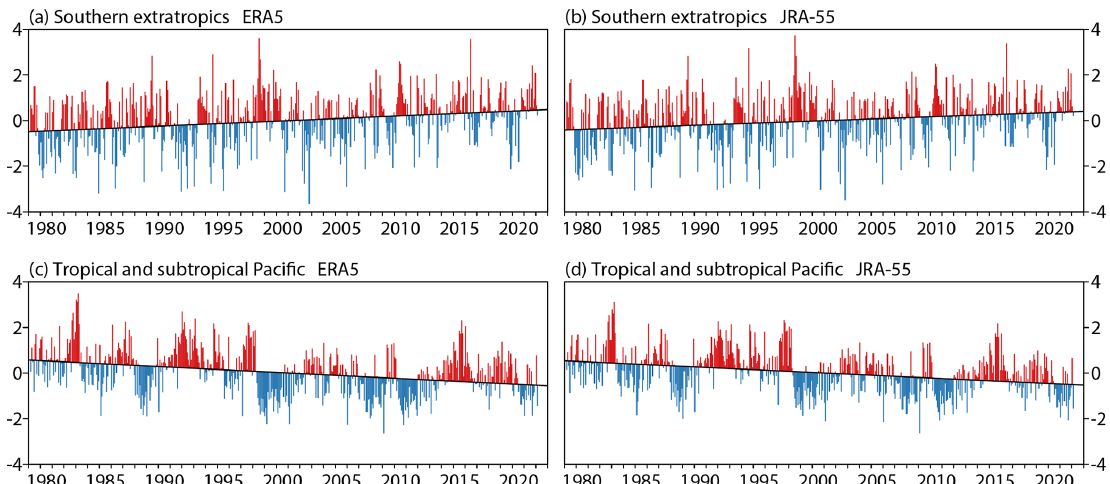
Figure 19. Monthly means of 850hPa zonal winds (ms − 1 ) averaged over the southern extratropics (45–60 ◦ S) for (a) ERA5 and (b) JRA-55, as well as over central latitudes of the Pacific (30 ◦ N–30 ◦ S, 160 ◦ E–120 ◦ W) for (c) ERA5 and (d) JRA-55. They are shown relative to the average for each month in the period from March 1979 to February 2022 and plotted according to whether they are above (red) or below (blue) the least squares fit linear trend for this